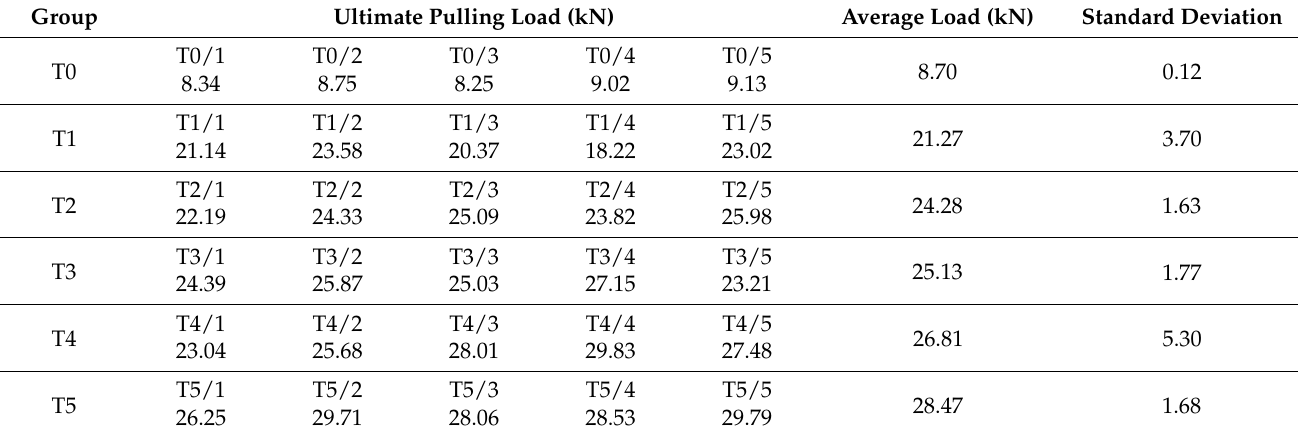
Table 6. Experimental data of the tensile strength of connections.